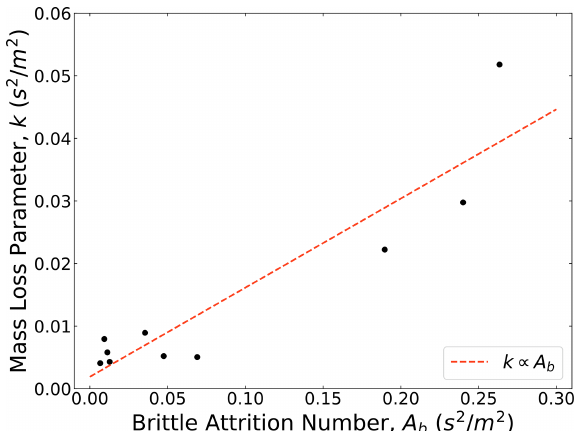
Figure 8. Relation between the empirically determined mass loss parameter, k , and the brittle attrition number determined from ma- terial properties, A b (Miller and Jerolmack, 2020); the best-fit linear relation is k = 0 . 142 A b + 0 . 0019, where R 2 = 0 . 85. Thus, the ex- perimental constant C 1 = 0 .